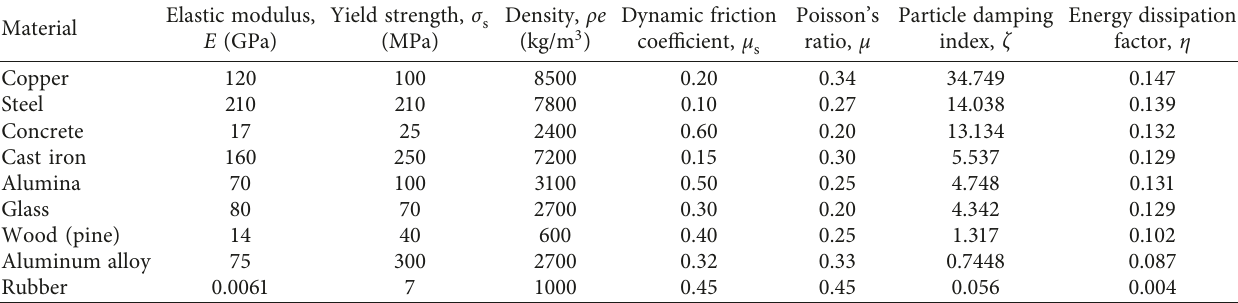
Table 1: Physical properties and energy consumption of various